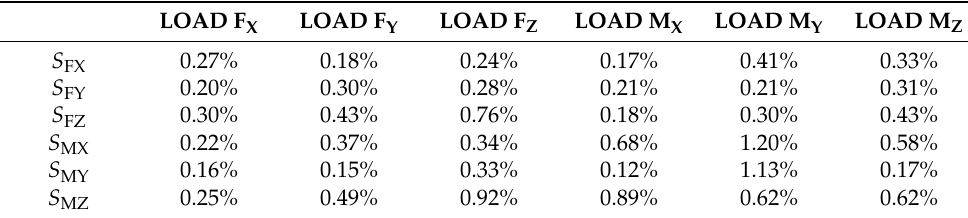
Table 10. Analysis of average measurement error and crosstalk of 32 strain gage arrangement.